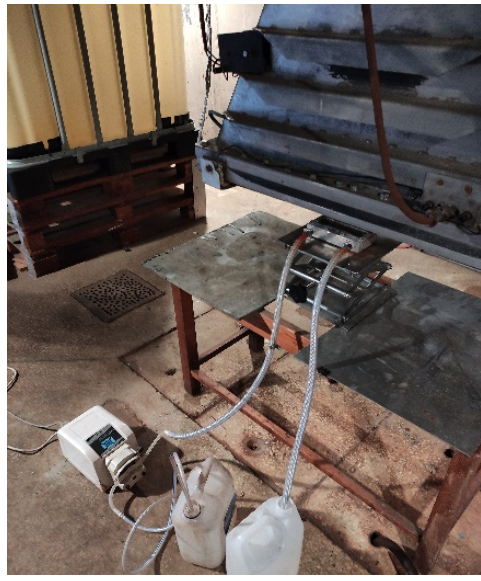
Figure 4. FIS installation used for the flow irradiation of sewage sludge connected to an ILU-6 electron accelerator. Irradiated sludge was pumped by peristaltic pump (on the left ) from one container to irradiation cassette located below accelerator exit window (on the top ), and then received in the second container (on the bottom ).